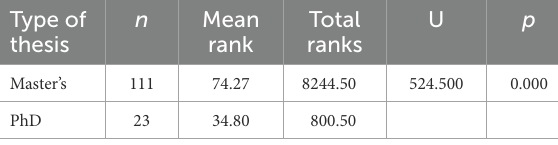
TABLE 9 U-Test results of similarity indexes of postgraduate theses in Turkey grouped by thesis